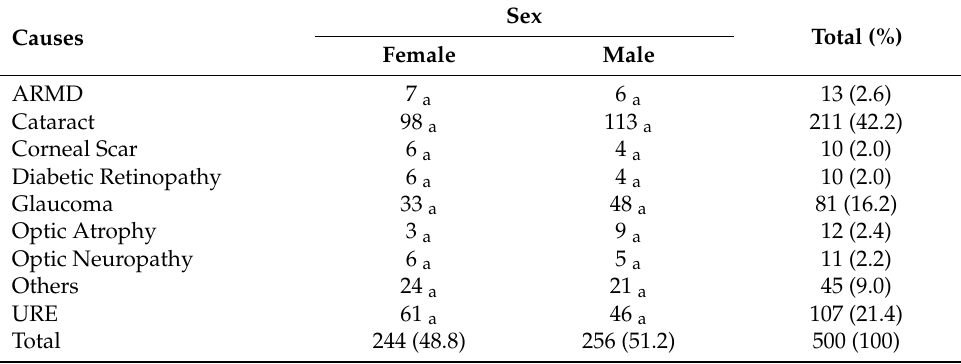
Table 6. Association between sex and causes of VI and